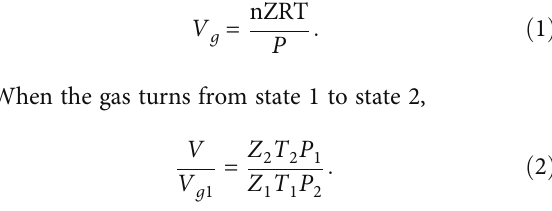
foam quality of variable 2